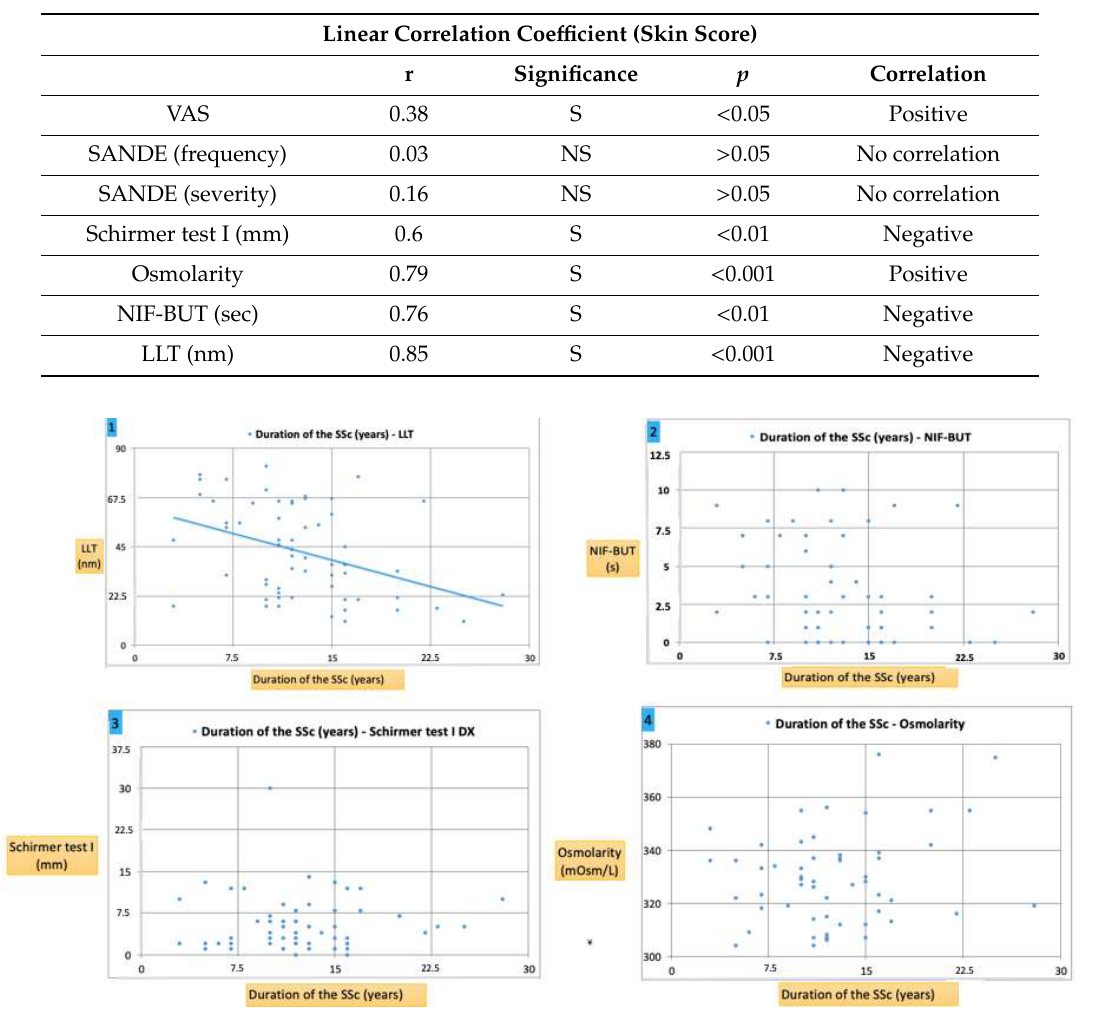
Table 4. Linear correlation of the VAS, SANDE (frequency), SANDE (severity), Schirmer test I, osmolarity, NIF-BUT, and LLT with the skin score.